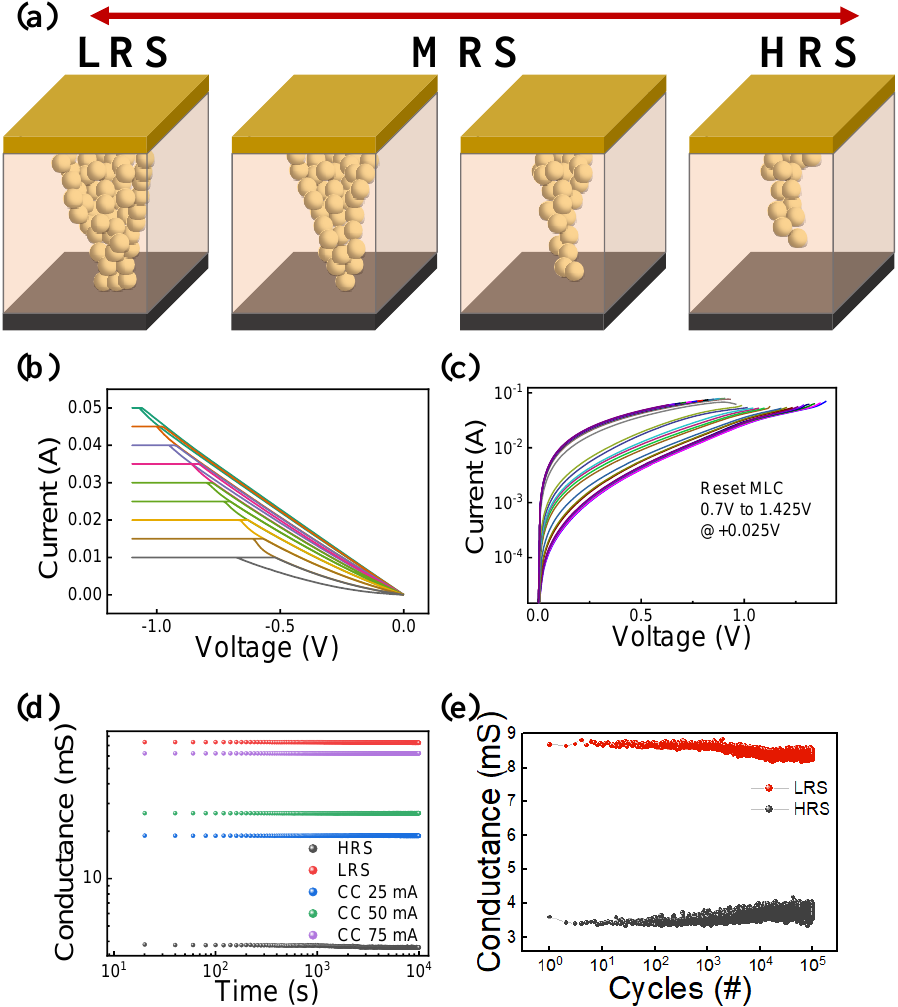
Figure 3. ( a ) Schematic diagram of the filament for each state. MLC characteristics: ( b ) in set region, ( c ) in reset region. ( d ) Multi-states retention characteristics for 10 4 s, ( e ) endurance characteristic of the device for 10 5 cycles.